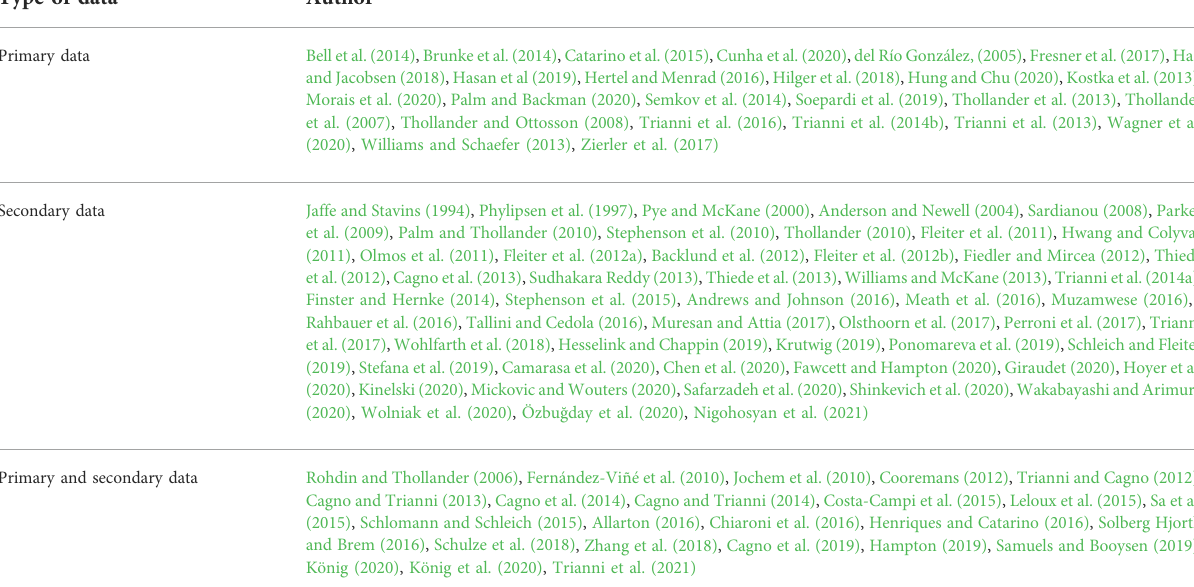
TABLE 4 Classi fi cation of articles by type of